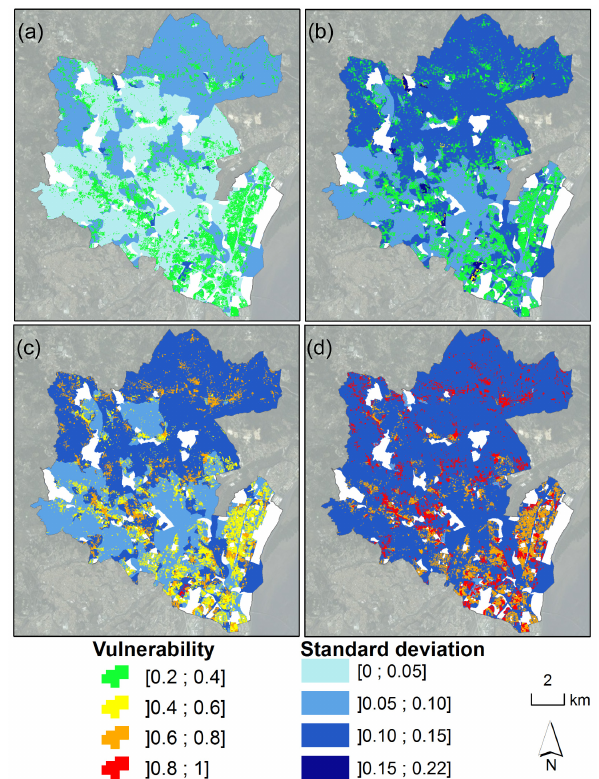
Figure 8. Average building vulnerability and standard deviation per BGRI subsection, for buildings located on a landslide foot with an affected material height of (a) 0.5m, (b) 1m, (c) 3m, and (d) 5m. White polygons are BGRI subsections without